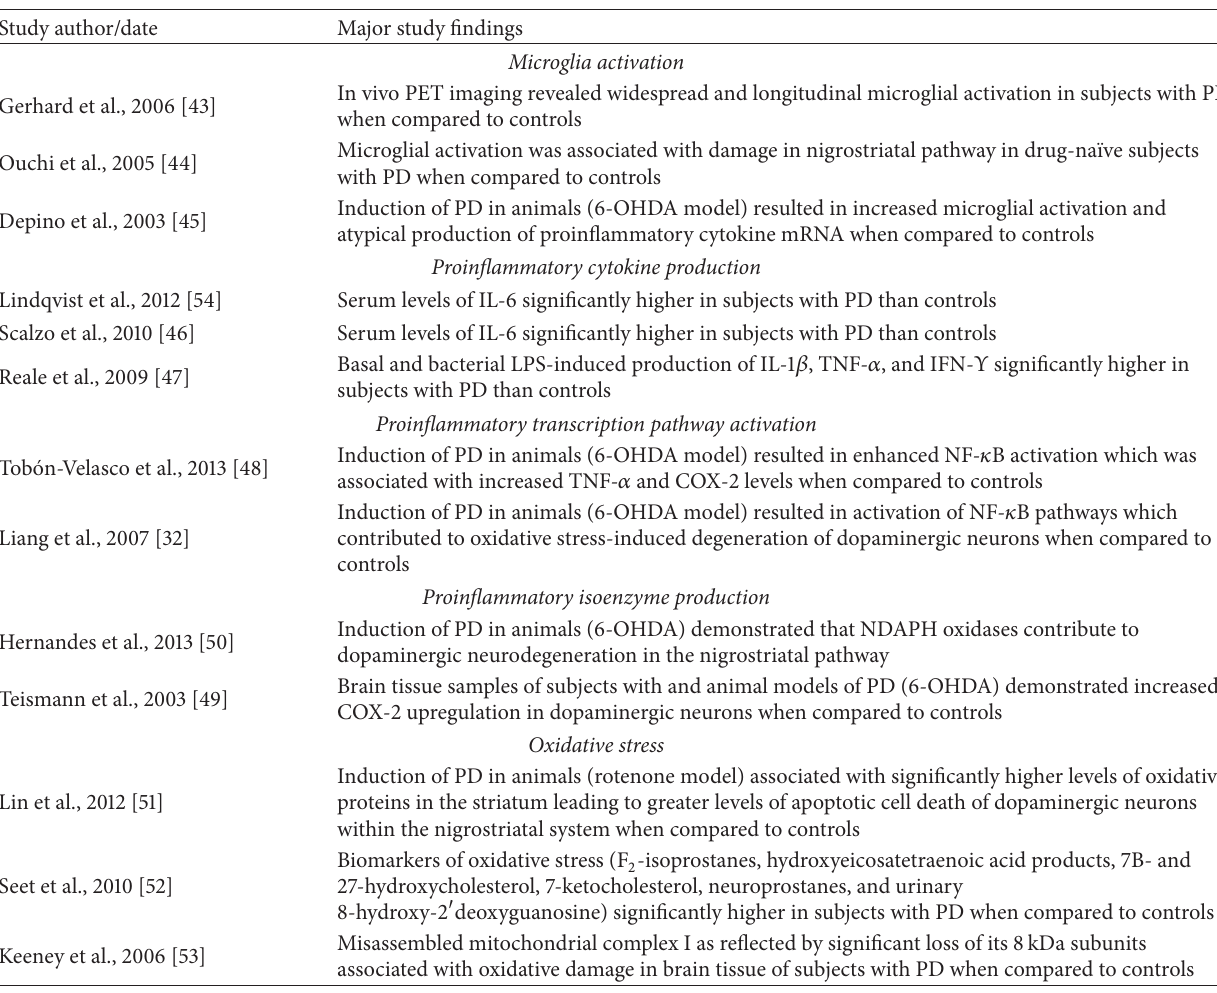
Table 2: Potential biological mechanisms of neuroinflammation and oxidative stress associated with neurodegeneration in